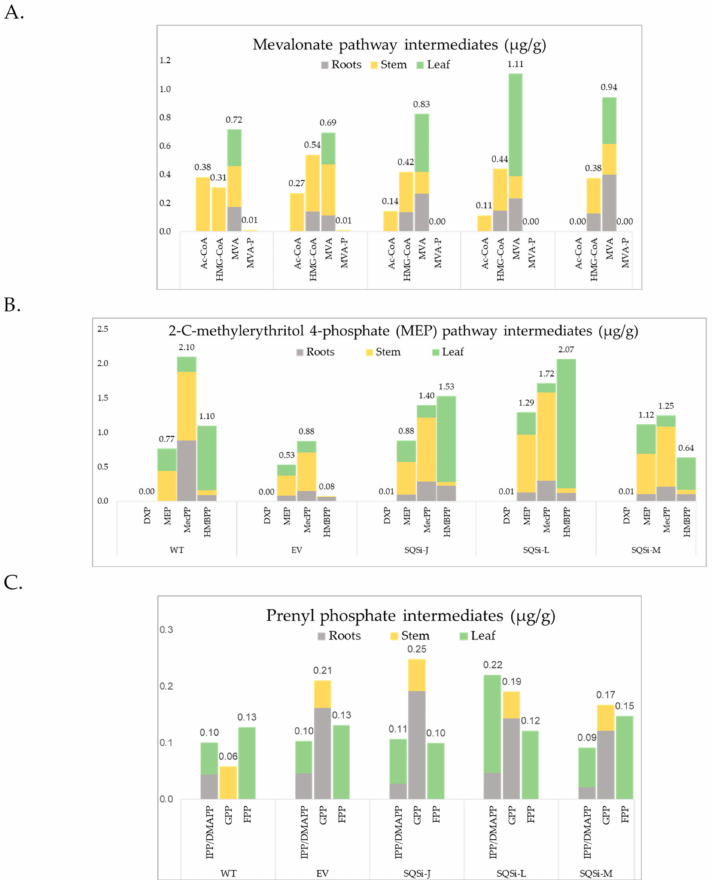
Figure 5. Effect of SQS downregulation on isoprenoid intermediates. Concentrations (ug/g dry weight) of metabolites in 5-month-old guayule plant tissues including: ( A ) the cytosolic mevalonic acid pathway intermediates: acetyl coenzyme A (AC-CoA); acetoacetyl coenzyme A (Acac-CoA); hy- droxymethylglutaryl coenzyme A (HMG-CoA); mevalonate (MVA); mevalonate-5-phosphate (MVA- P); and mevalonate diphosphate (MVA-PP). ( B ) The methylerithritol phosphate pathway (chloro- plast) intermediates: pyruvate and glyceraldehyde-3-phosphate (G3P); 1-deoxylulose-5-phosphate (DXP); methylerythritol-4-phosphate (MEP); 4-(cytidine-5 (cid:48) diphospho)-methylerythritol (CDP-ME); methylerythritol-2,4-cyclodiphosphate (CDP-MEP), 2-C-methyl-d-erythritol 2,4-cyclodiphosphate (MEcPP); and 4-hydroxy-3-methylbut-2-enyl diphosphate (HMBPP). ( C ) Also shown, common prod- ucts of both pathways: isopentenyl pyrophosphate (IPP)/dimethylallyl diphosphate (DMAPP), geranyl diphosphate (GPP), farnesyl diphosphate (FPP), squalene, and natural rubber. Values repre- sent the average of 3 biological